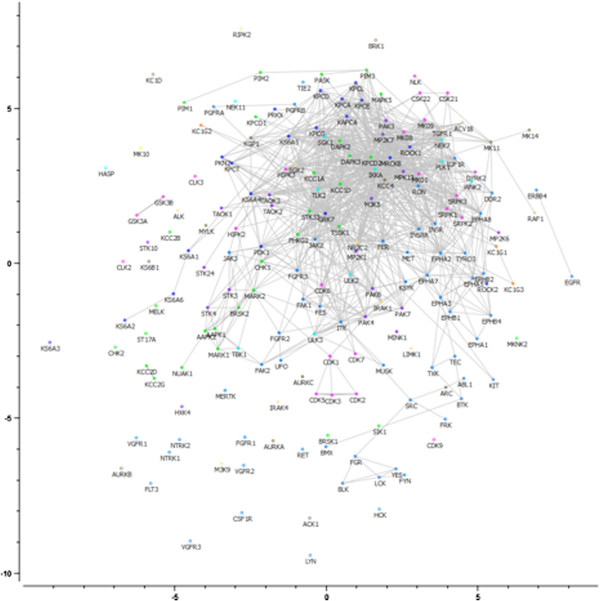
Multi-dimensional scaling (MDS) of kinases in bioactivity space after omission of kinases with too few shared activities. Kinases are colored according to their sequence-based classification [5]. A low average signed relative stress level of 0.28 was obtained, meaning that the 2D representation of the kinases involves a low loss of information. Gray lines connect similar kinases. The outliers, based on fingerprint enrichment profiles, are grouped in 2 clusters (indicated by a red line), located far away from each other in bioactivity space, rather than a large one. The kinases VEGFR3, ACK1 and LYN are located far away from the non-outlier kinases, whereas the kinases CSK21, CSK22, IGF1R and WNK2 are located much closer to the non-outliers.